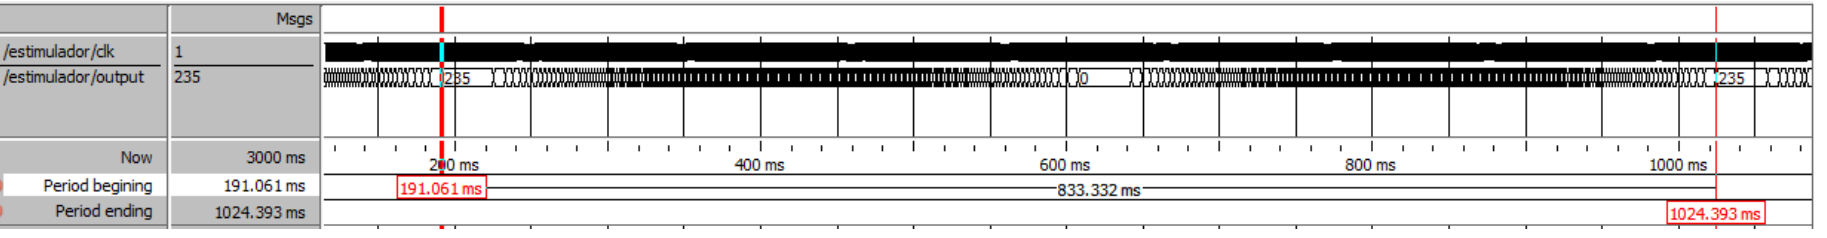
Figure 22. Error analysis for a SPSS stimulus with amplitude of ±30° at 1.2 Hz with D = 100 cm.